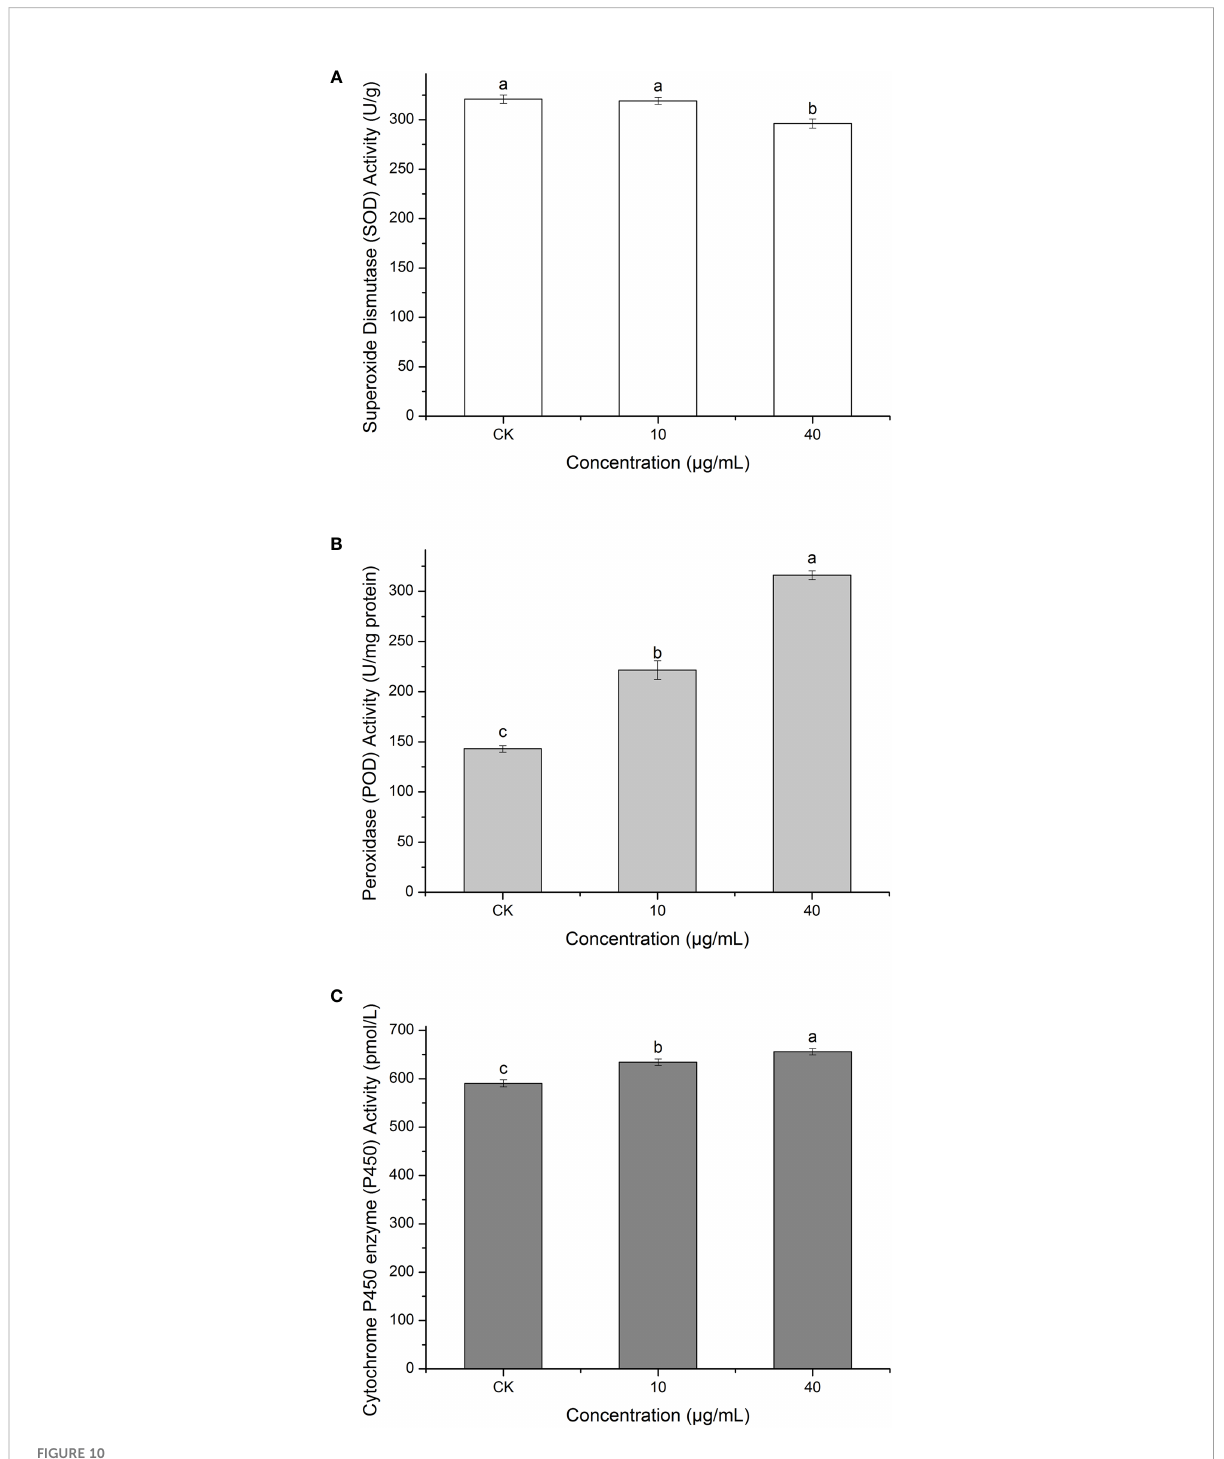
FIGURE 10 Effect of the antifungal compound PCN on the enzymatic activities of R. solani AG1IA. (A) superoxide dismutase (SOD); (B) peroxidase (POD); (C) cytochrome P450 monooxygenase; different lowercase letters indicate signi fi cant differences ( P < 0.05